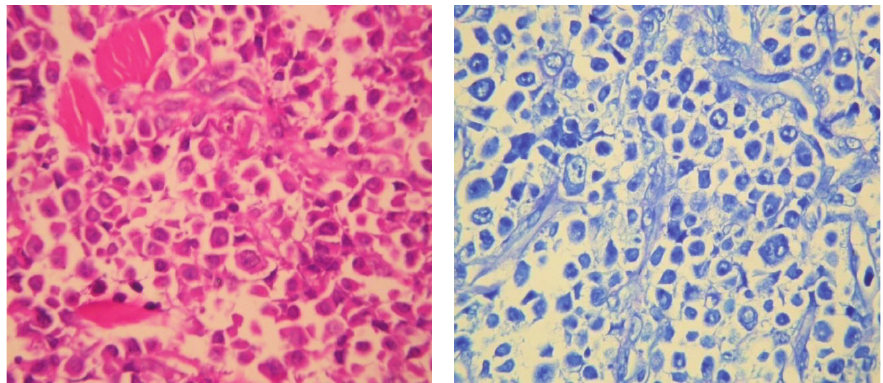
Figure 4: Skin biopsy samples show neoplastic cell infiltration and collagen